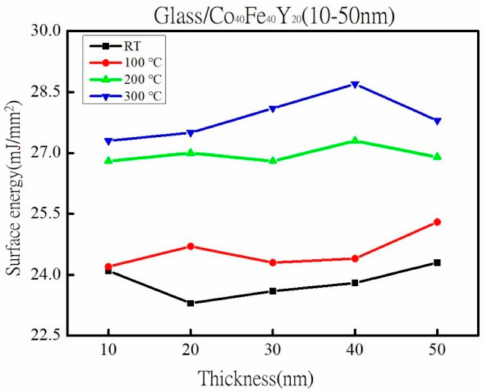
Figure 8. The surface energy under four